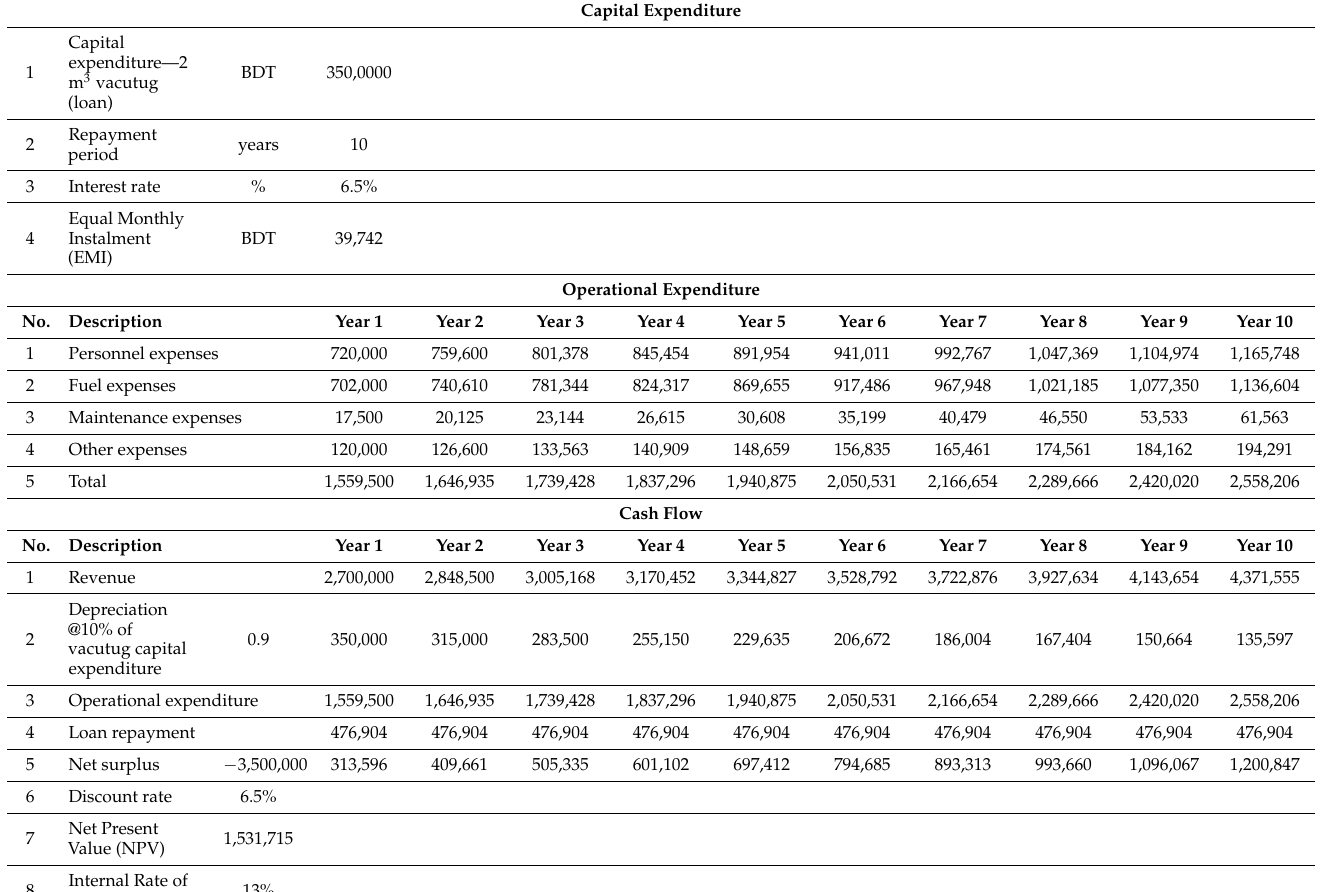
Table 3. Financial analysis of 2 m 3